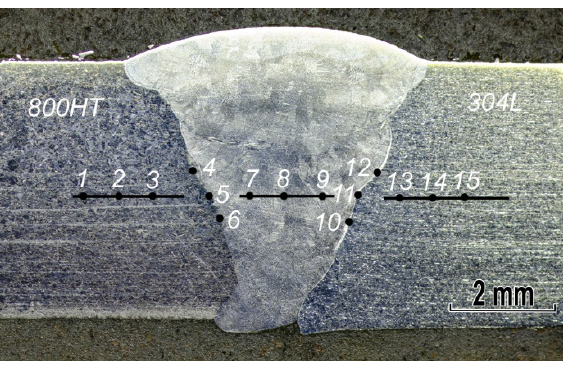
Figure 17. The arrangement of measurement points on the specimen for microhardness measurements.